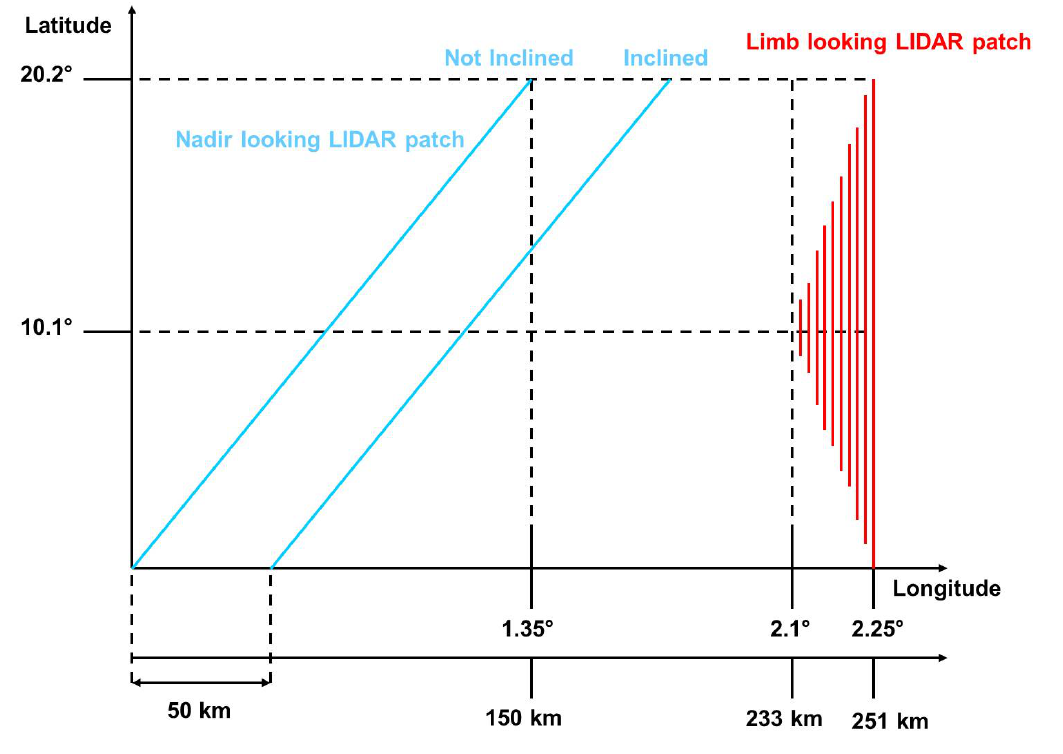
Figure 4. Representation of the ground-track offset between limb and nadir measurements, for 0 to 20 ◦ latitude. The offset arises because of the rotation of the Earth between nadir and limb measurements.The nadir LiDAR will be inclined to minimise returns from specular reflection; this inclination can be utilised to minimise the offset (5 ◦ inclination